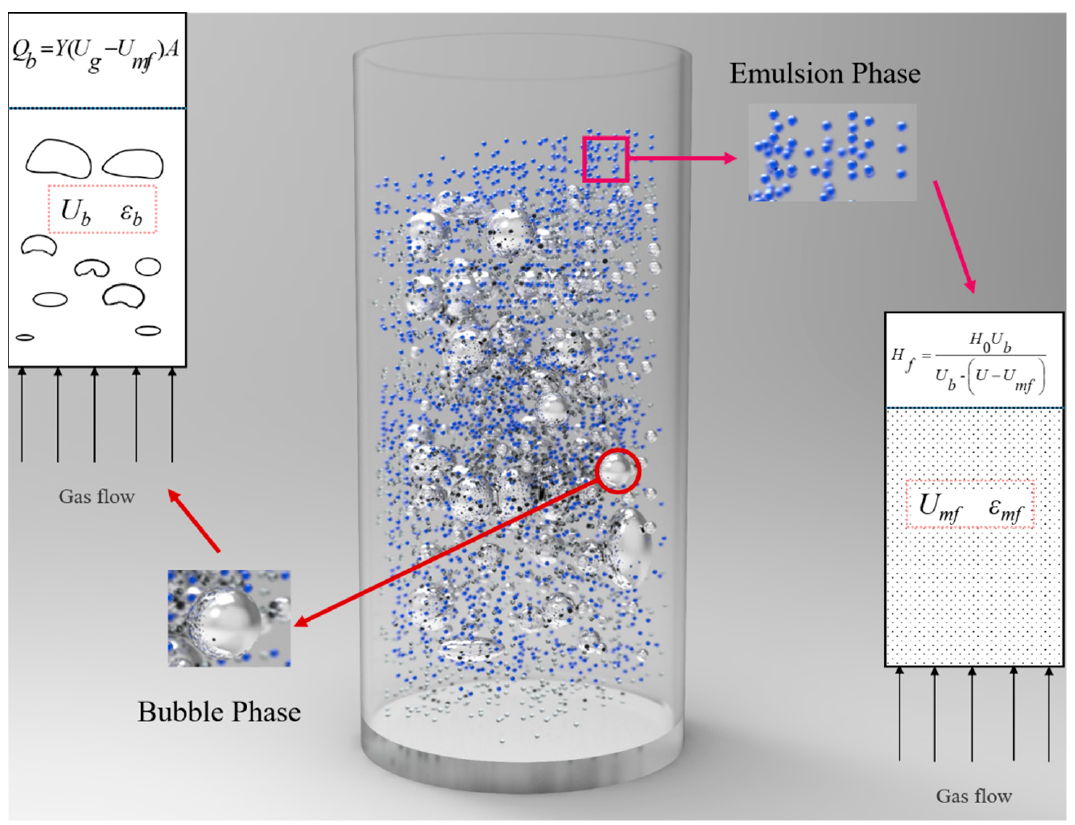
Figure 4. Schematic diagram of the original two-phase theory.